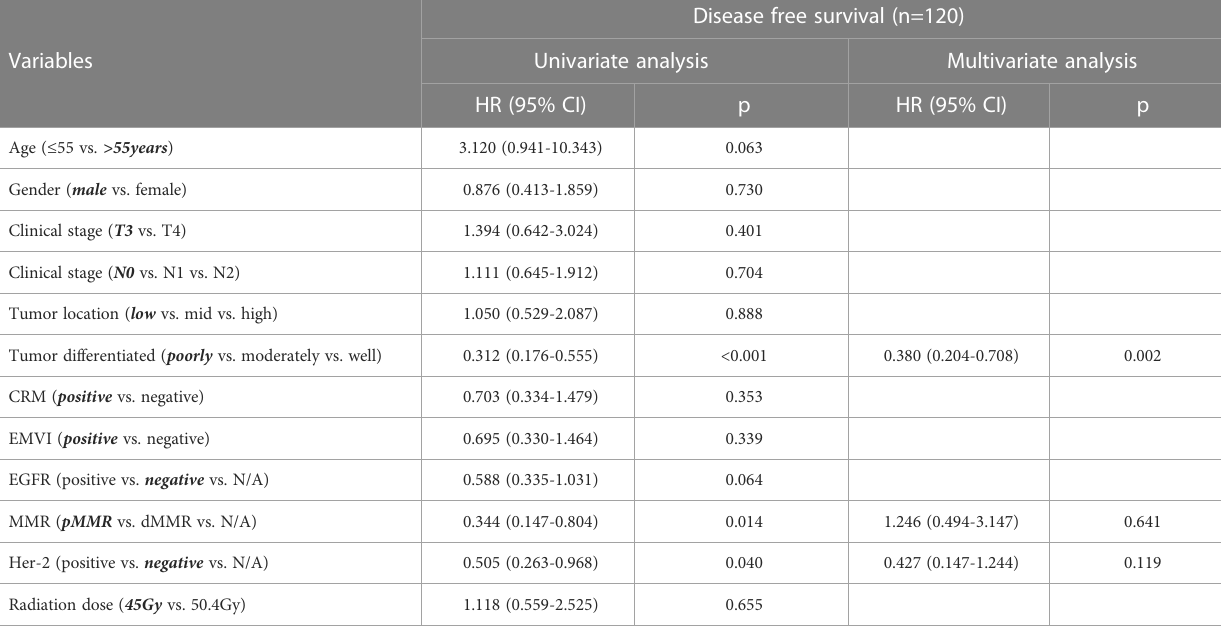
TABLE 4 Univariate and multivariate Cox regression analyses for different variables and DFS in LARC patients.